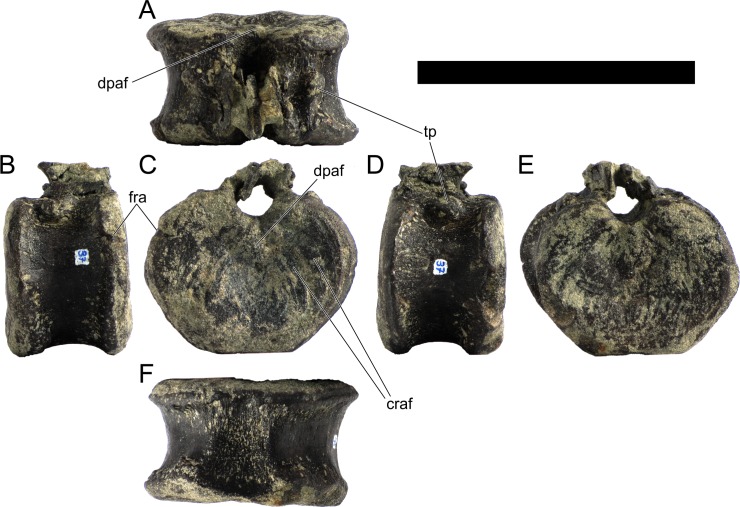
Caudal vertebra 32 of Miragaia longicollum MG 4863.A, dorsal, B, right lateral, C, anterior, D, left lateral, E, posterior, and F, ventral view. Craf, concentric ridges of articular facet, dpaf, dorsal process of articular facet, fra, fracture, tp, transverse process. Scale bar equal to 10 cm.